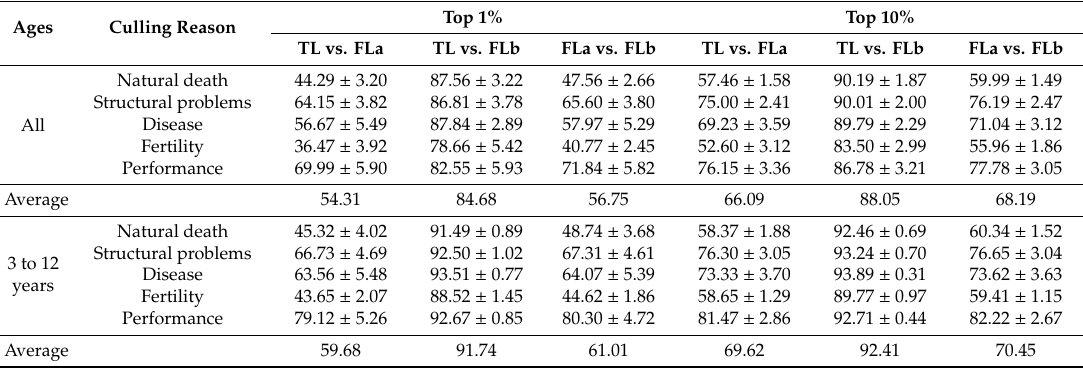
Table 7. Average ( ± SE) proportion of animals commonly selected between the di ff erent 1 longevity definitions considering all ages (i.e., from 2 to 15 years) and ages between 3 and 12 years-old, for the top 1% and 10% sires, with more than 5 daughters with phenotypic records, of all groups of known culling